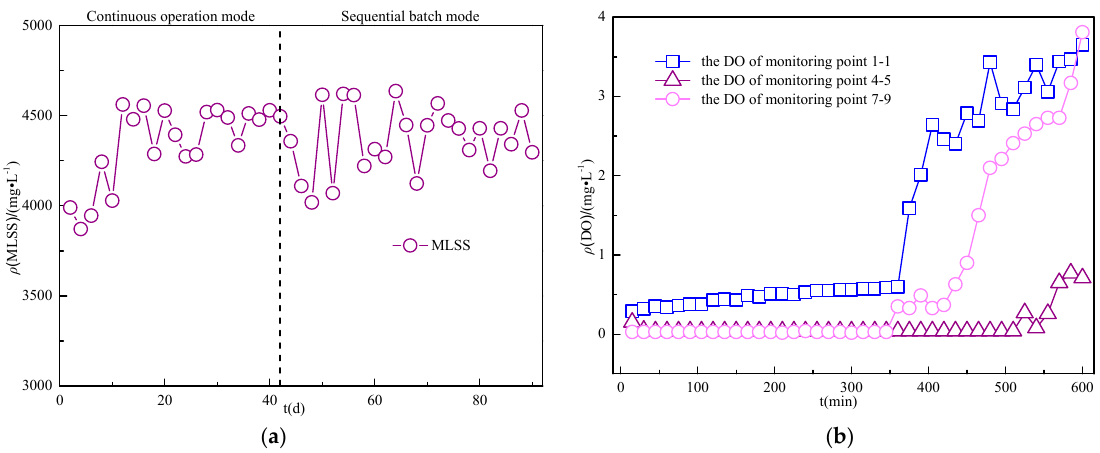
Figure 6. MLSS change during MPSR operation and DO change during sequential batch operation. ( a ) is the change of MLSS during the operation of MPSR, ( b ) is the time variation of the sampling point DO within the typical batch MPSR cycle time.